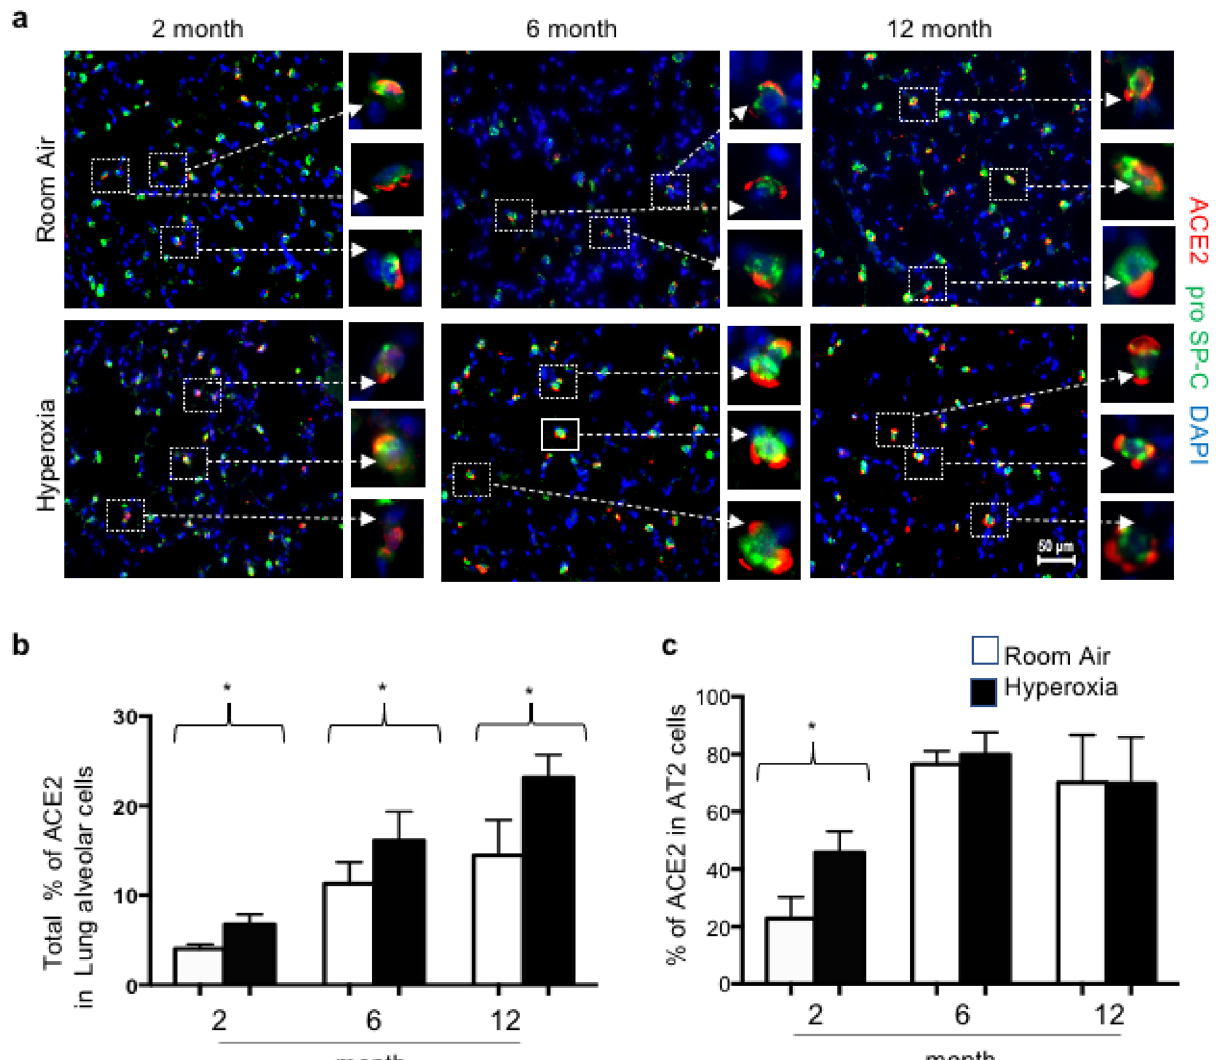
Figure 4. Neonatal hyperoxia stimulates expression of ACE2 in alveolar type 2 cells. ( a ) Lungs of 2-, 6- and 12-month-old mice exposed to room air or hyperoxia between pnd0-4 were stained for ACE2 (red), proSP-C (green), and DAPI. Upper rows reflect room air and lower rows reflect hyperoxia between PND0-4. Boxed regions are enlarged to the right of each image. ( b ) The proportion of ACE2-positive to total DAPI cells was quantified in 5 random fields taken from 5 mice per group and graphed. ( c ) The proportion of proSP-C + cells that express ACE2 were quantified in 5 random fields taken from 5 mice per group and graphed. Values in b and c represent mean ± SD of 4–5 lungs per group. Statistical significance is comparisons for all pairs using Tukey– Kramer HSD test with*P ≤